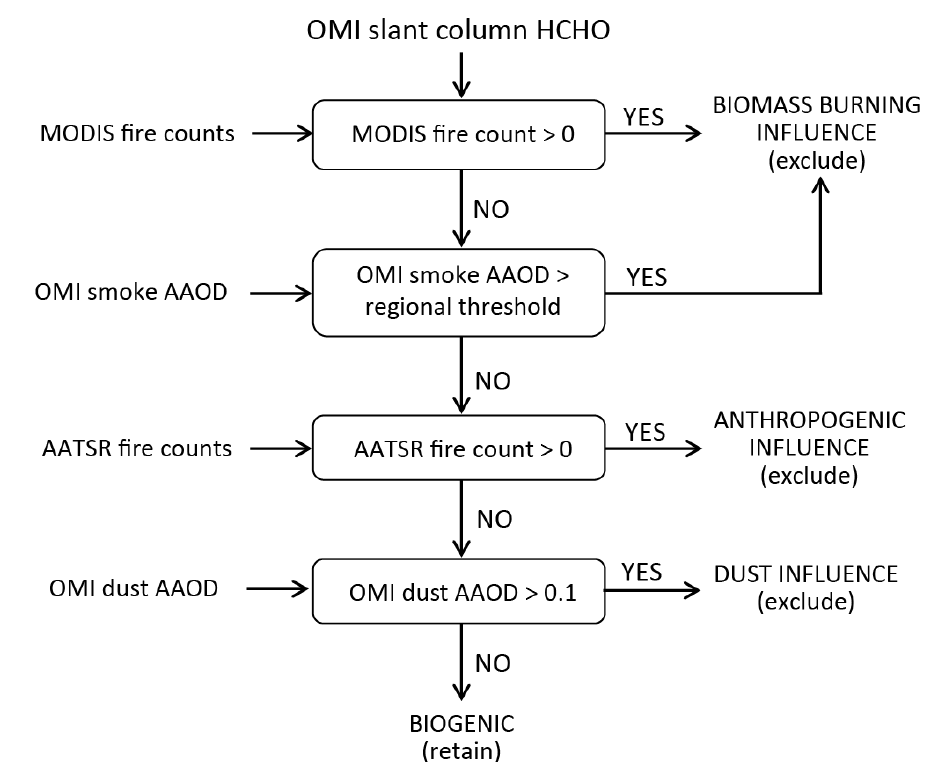
Fig. 3. Flow chart of the filtering algorithm used to remove biomass burning, dust, and anthropogenic influences in OMI slant HCHO columns ( (cid:127) s ). All data are 8-day averages on the same 1 × 1 ◦ grid. The MODIS fire counts filter uses MODIS data for the 8-day periods preceding and concurrent with the OMI HCHO